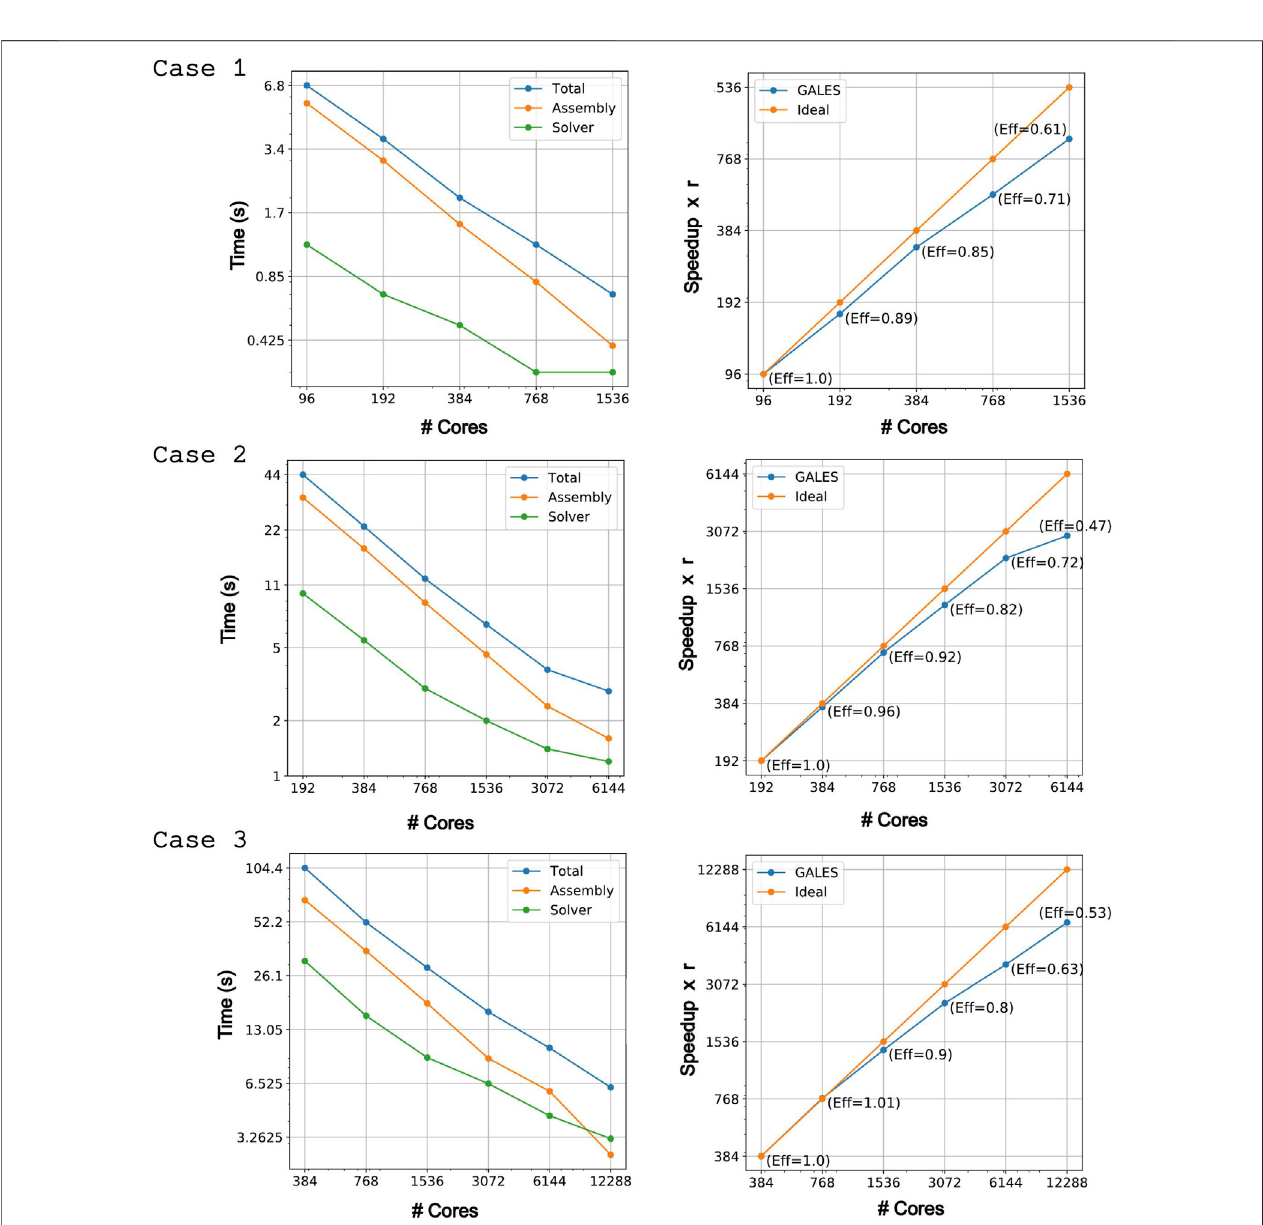
FIGURE 12 | Strong scaling results for test cases in Table 2